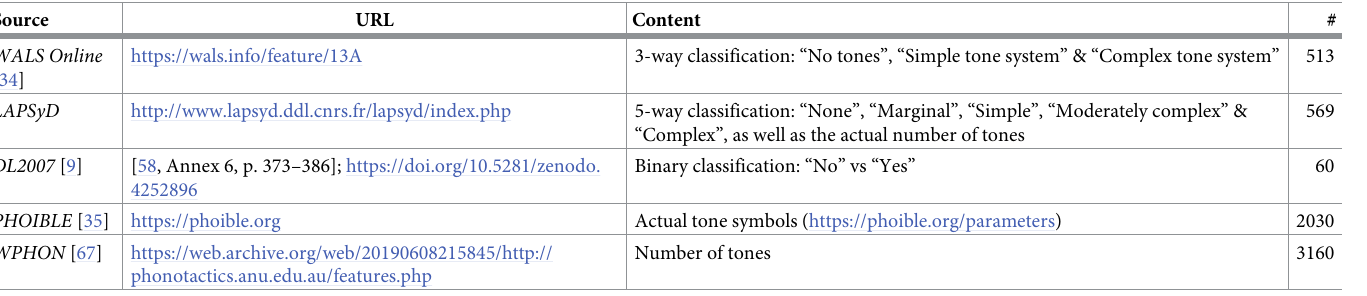
Table 4. Data sources for linguistic tone with the number of languages (the “#” column).